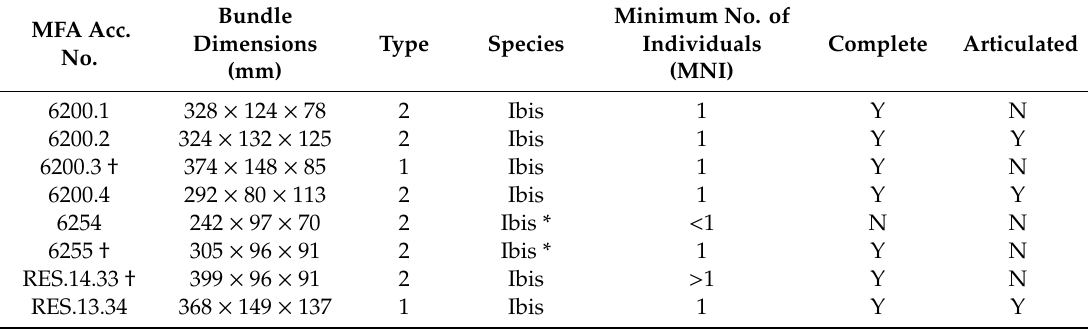
Table 1. Table summarizing the radiographic findings for the eight mummies in the study group. MFA Acc.